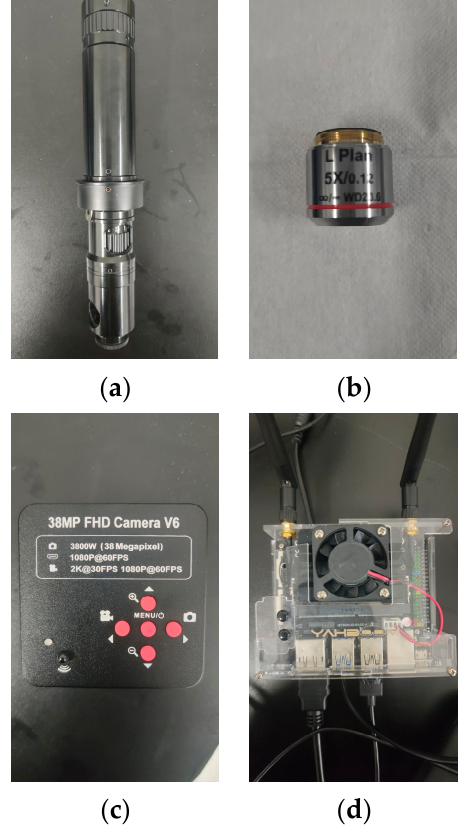
Figure 1. Oil-particle image-detection platform: ( a ) Small coaxial optical industrial microscope; ( b ) Objective lens; ( c ) CCD image sensor; ( d ) Jetson Nano device. The image collected by the CCD image sensor communicates with Nvidia’s Jetson Nano device (Figure 1d) through a USB interface. The device has a GPU to facilitate subse- quent image processing operations. After image processing, the image will be transmitted to the display screen through the antenna on the device.